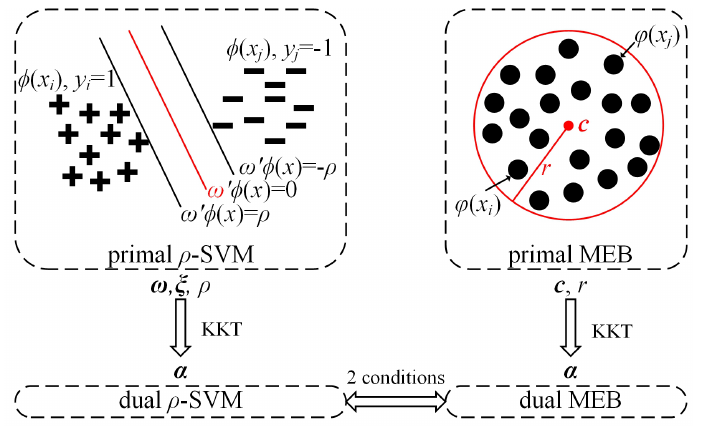
Figure 1. Equivalence of the SVM and